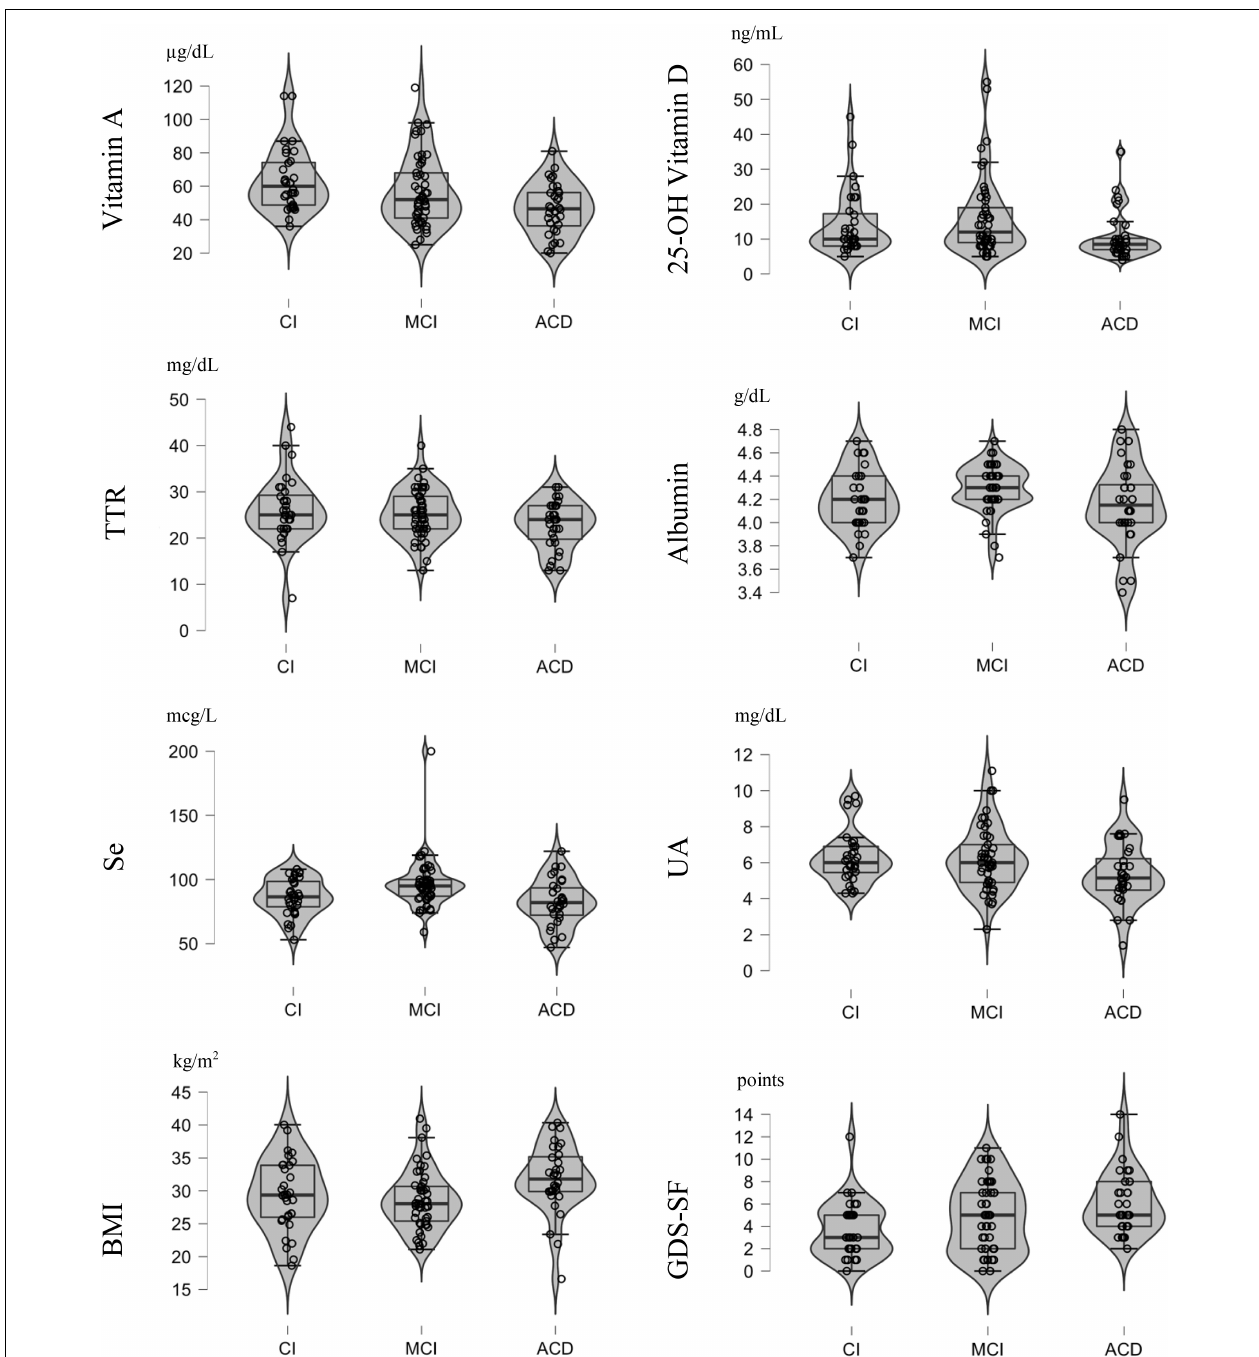
FIGURE 1 | Distribution graphs of the variables which achieved statistically significant differences across cognitive status groups (CI, Cognitively Intact; MCI, Middle Cognitive Impairment; ACD, All Cause Dementia).